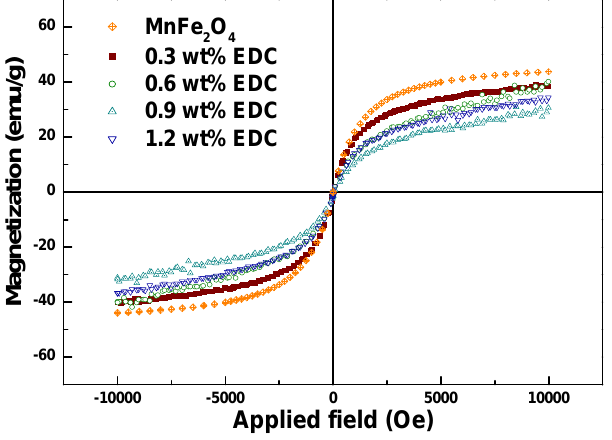
Figure 6. Magnetization curves for the DMSA-MnFe formed using different amounts of